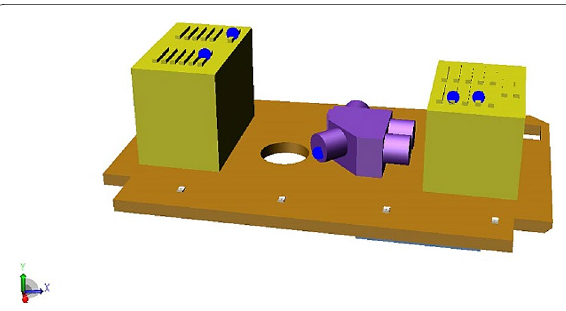
Figure 11 Endpoints in the first scenarios